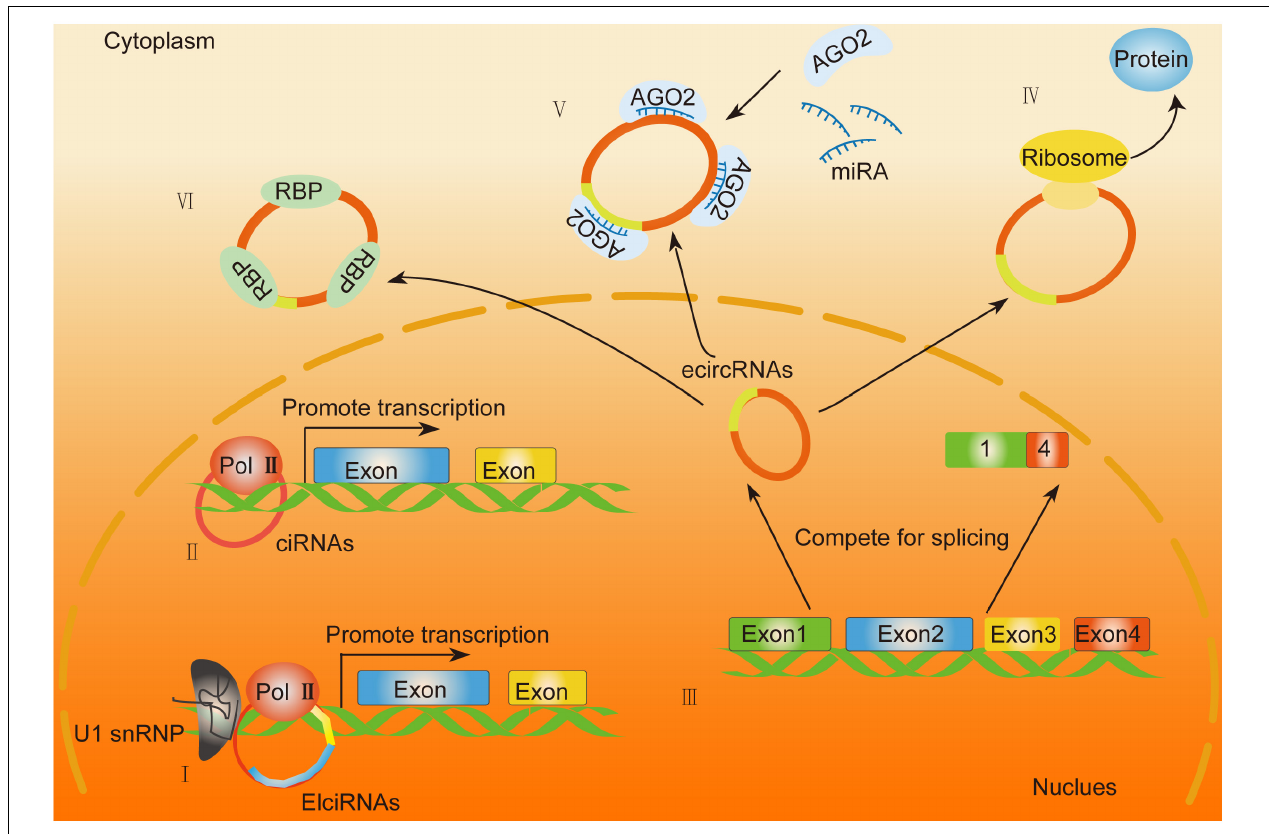
FIGURE 2 | General biological functions of circRNAs. (I,II) EIciRNAs and ciRNAs function as enhancers of specific proteins by binding with the RNA polymerase II (Pol II) complex. (III) EcircRNAs are generated through back-splicing and translocate from the nucleus into the cytoplasm. (IV) Exonic circRNAs that contain internal ribosome entry sites (IRES) or prokaryotic binding sites translate into peptides. (V) EcircRNAs function as miRNA sponges. (VI) EcircRNAs can act as a decoy or scaffold to sequester proteins and regulate gene expression or functional protein